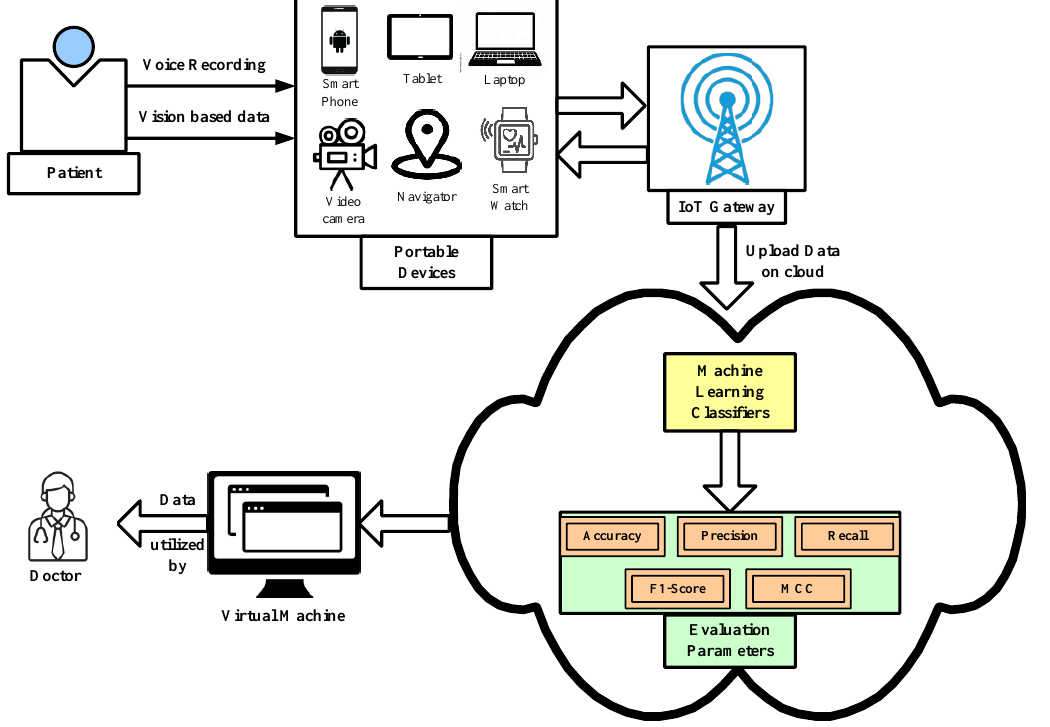
Figure 7. Proposed architecture of cloud and machine learning-based framework for the diagnosis of Parkinson’s disease . Parkinson’s